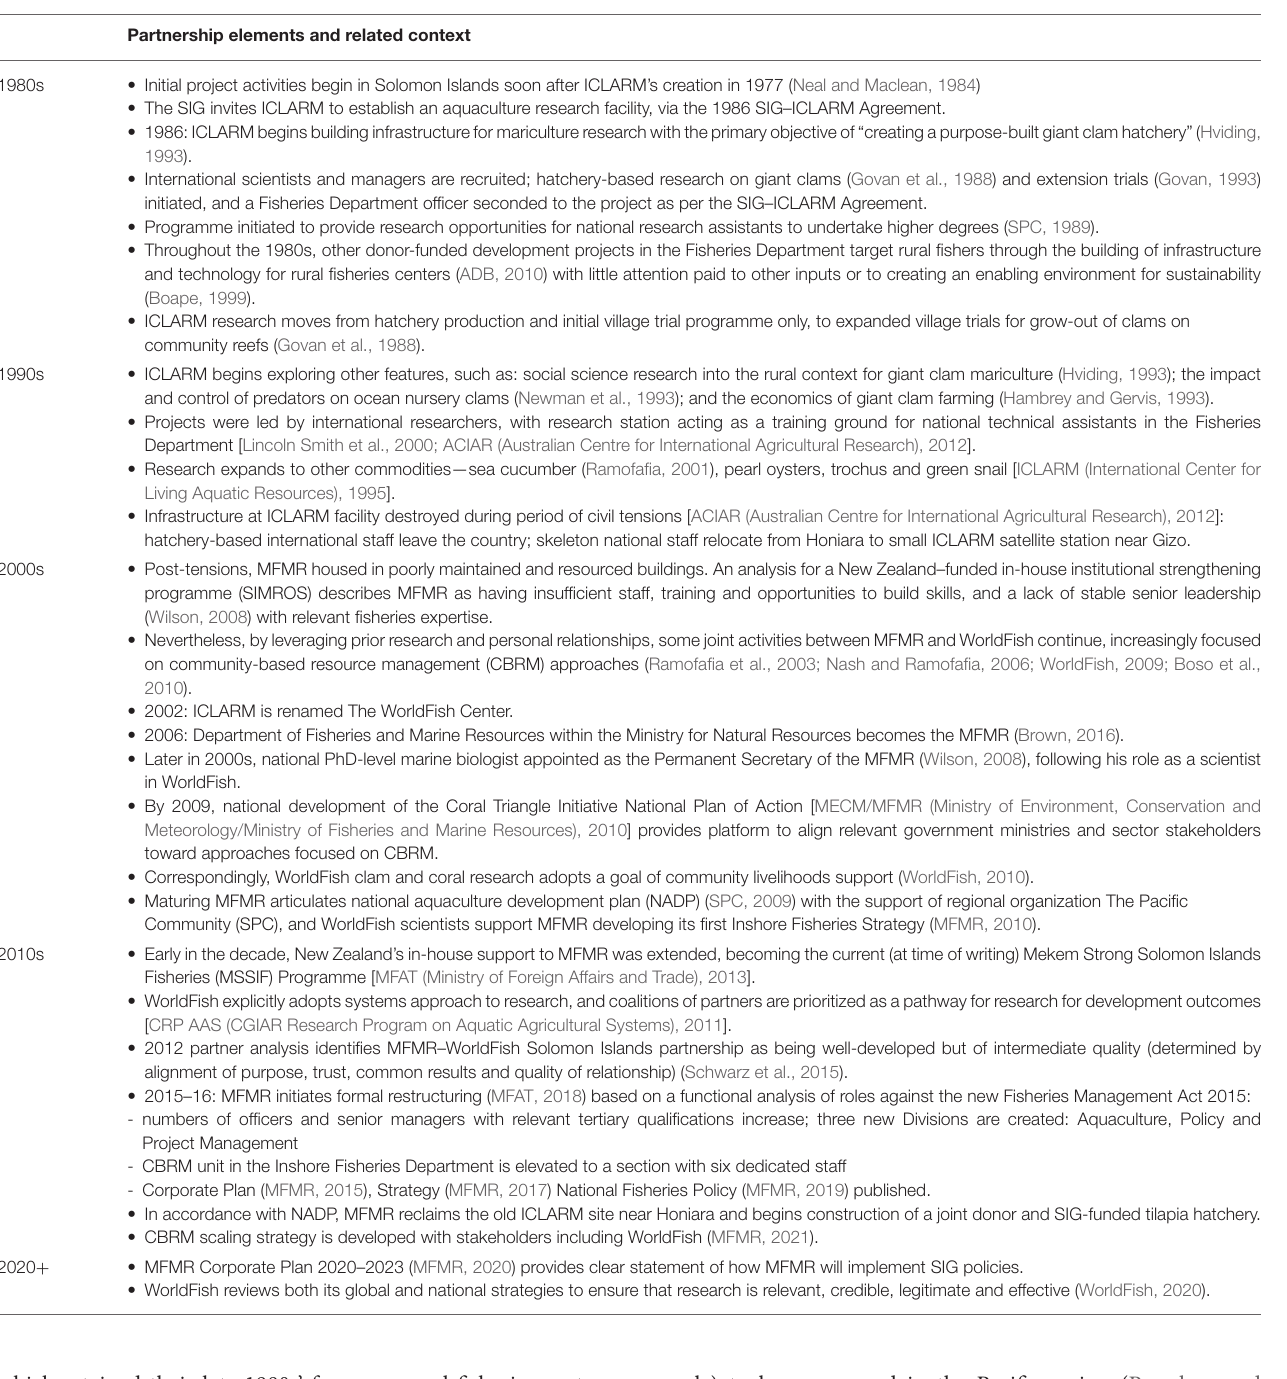
TABLE 1 | Summary of the institutional context for WorldFish (previously the International Center for Living Aquatic Resources Management; ICLARM) and the Ministry of Fisheries and Marine Resources (MFMR, previously the Department of Fisheries, within the Ministry for Natural Resources) of the Solomon Islands Government (SIG) in the small-scale fisheries and aquaculture sectors by decade, since